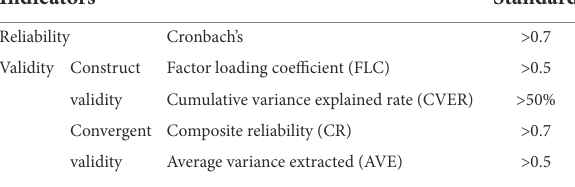
TABLE 2 The indicators of reliability and